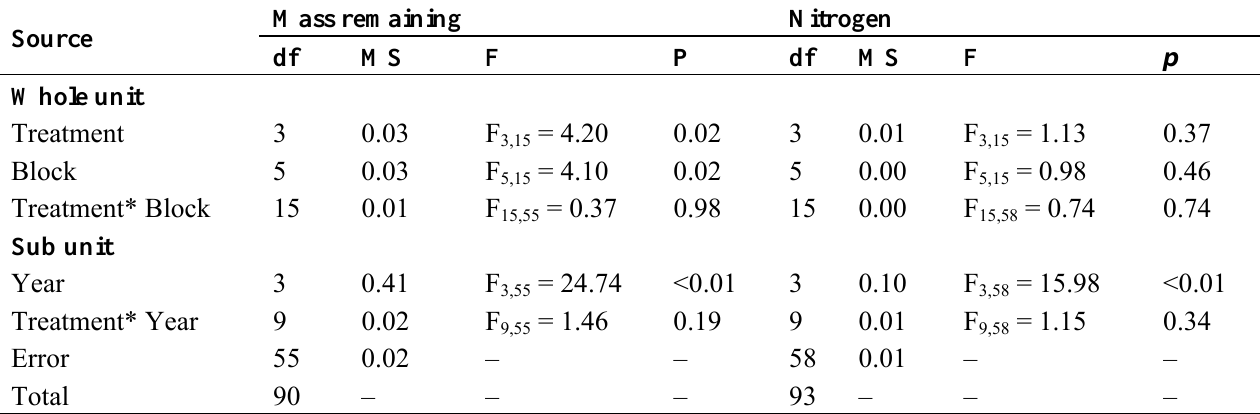
Table 3. Results from ANOVA (split-plot design) for percent mass remaining and nitrogen N concentration.